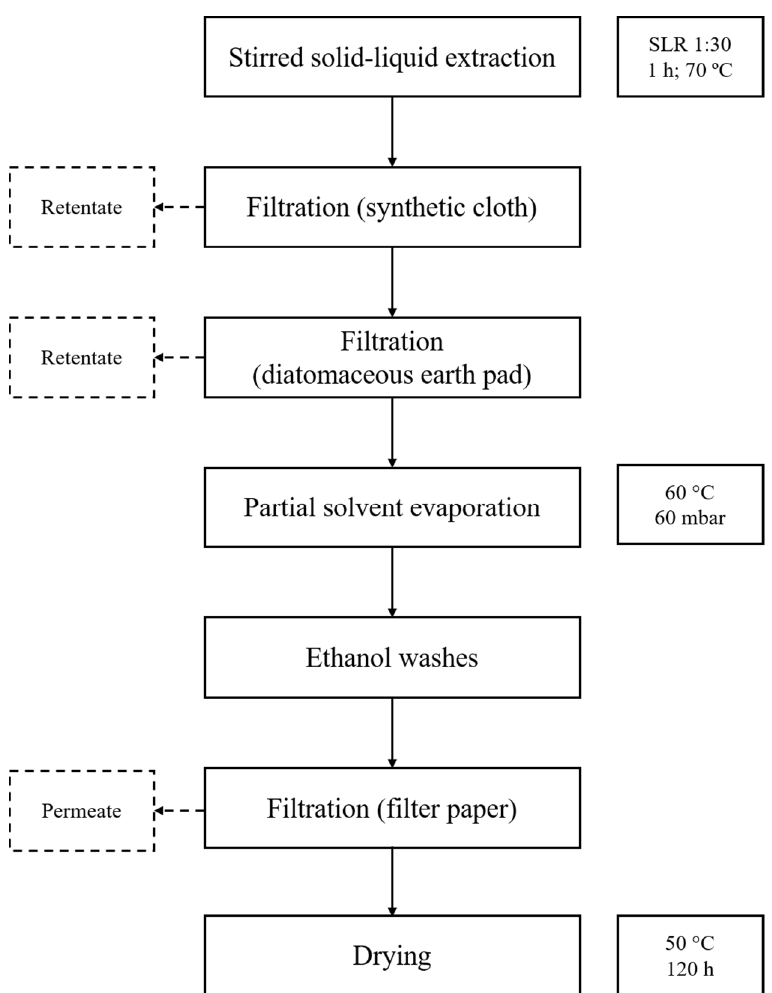
Figure 1. Flowchart of the extraction process used for obtaining aqueous P. dioica extracts. Dashed lines represent the rejected fractions of filtration.